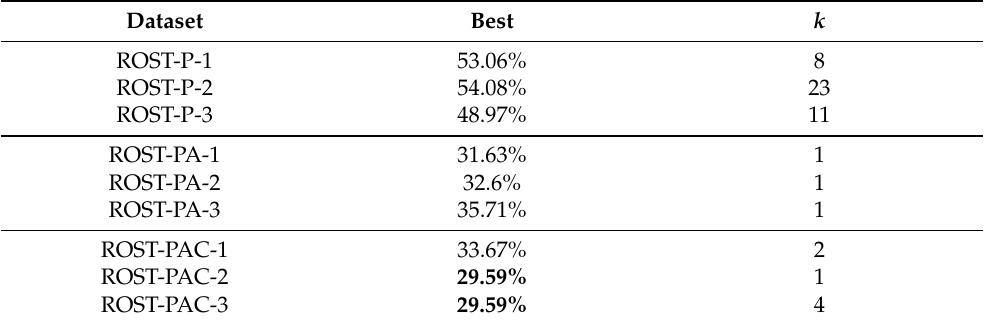
Table 13. k-NN results on the considered datasets. In total, 30 runs are performed with k varying with the run index. The number of incorrectly classified data is given as a percentage (the best results obtained by k-MM on any ROST-*-* dataset representation are in bold). Best stands for the best solution (out of the 30 runs), k stands for the value of k for which the best solution was obtained. Dataset Best k 53.06%